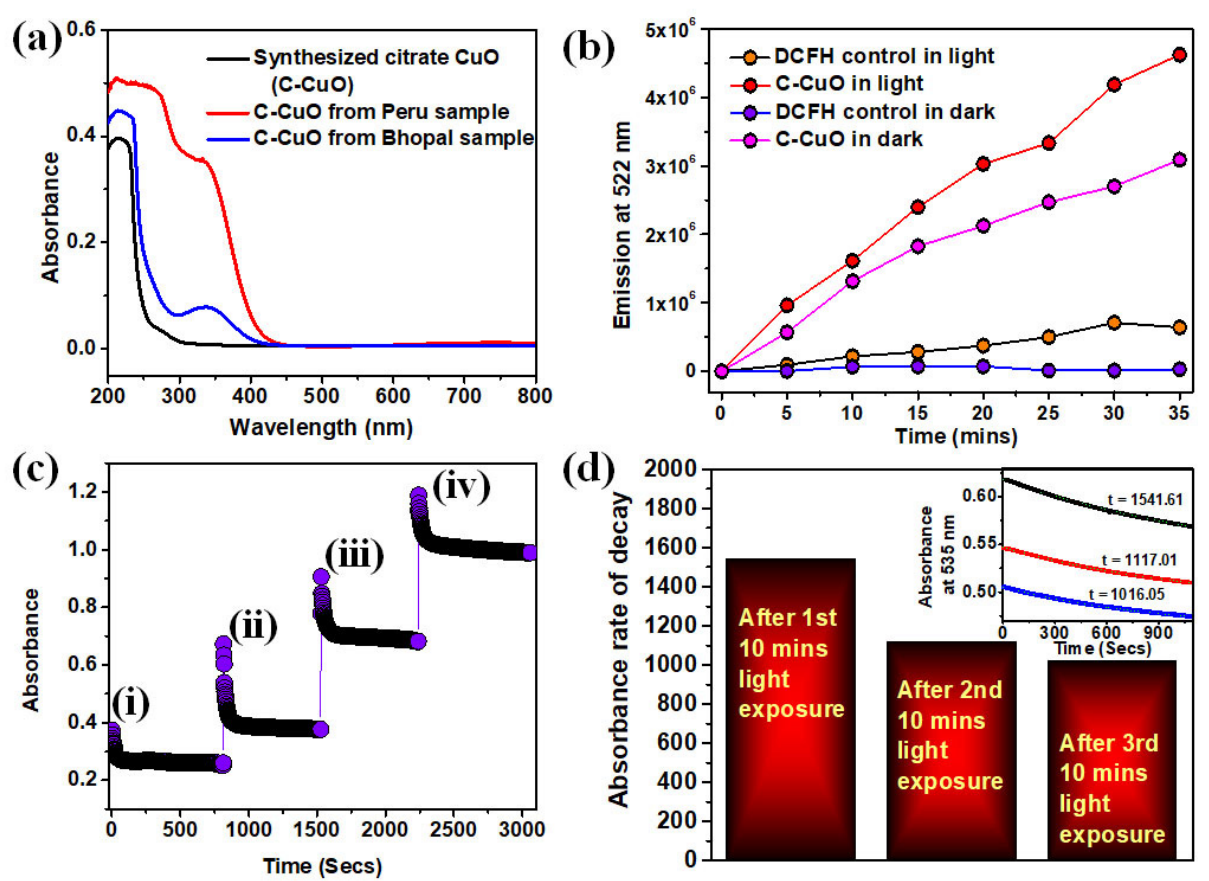
Figure 3. ( a ) Absorbance spectra of synthesized and extracted citrate-CuO nanohybrids. ( b ) DCFH oxidation (monitored at 522 nm) with time in the presence and absence of citrate CuO NPs under dark and illumination conditions. ( c ) The DPPH catalytic activity of the synthesized CuO NPs in dark conditions upon the addition of DPPH in periodic intervals of time (i) (ii) (iii) and (iv). ( d ) The DPPH assay of the synthesized CuO NPs under UV light illumination conditions. Inset shows the decay of absorbance of DPPH radical at 535 nm with multiple light exposures of 10 min intervals.